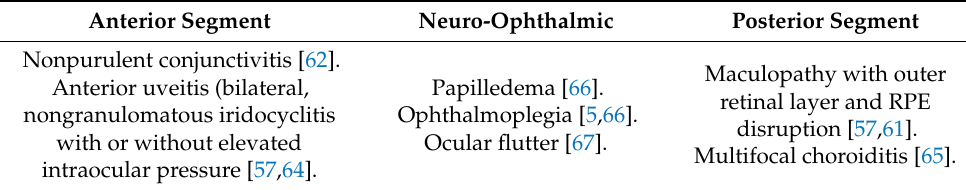
Table 1. Ocular findings documented in acute ZIKV infection. Anterior Segment Neuro-Ophthalmic Posterior Segment Nonpurulent conjunctivitis [62]. Maculopathy with outer Anterior uveitis (bilateral, Papilledema [66]. retinal layer and RPE nongranulomatous iridocyclitis Ophthalmoplegia [5,66]. disruption [57,61]. with or without elevated Ocular flutter [67]. Multifocal choroiditis intraocular pressure [57,64].